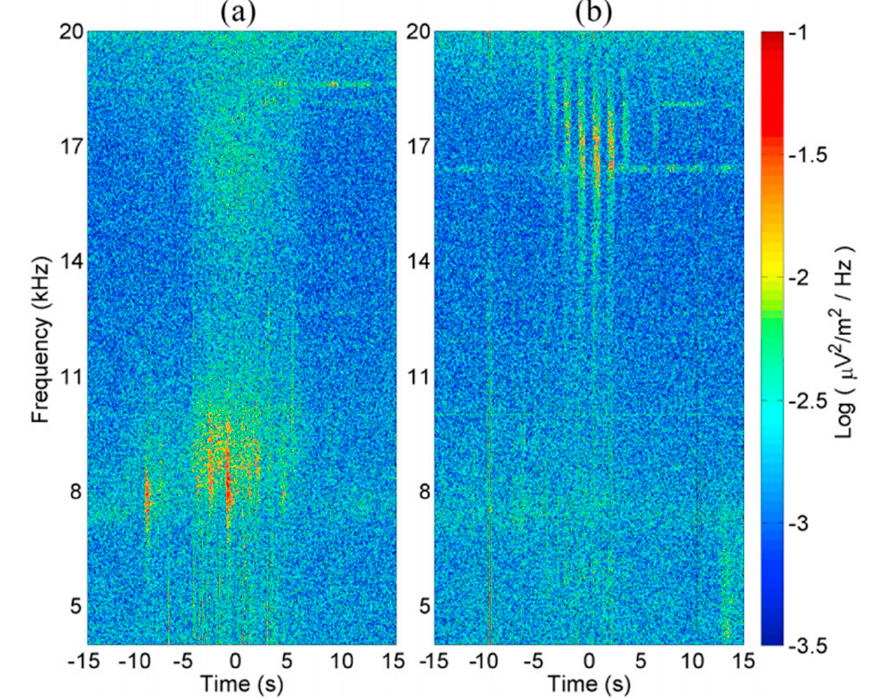
Figure 7. Spectrogram obtained by DEMETER during ( a ) Experiment 1 with CW heating and ( b ) Experiment 2 with 0.7 Hz square pulse modulated heating. In both cases, time = 0 corresponds to the closest approach of DEMETER to the magnetic zenith of HAARP (reproduced with permission from Vartanyan, A., Milikh, G.M., Eliasson, B., Najmi, A.C., Parrot, M., Papadopoulos, K., Genera- tion of whistler waves by continuous HF heating of the upper ionosphere; published by John Wiley and Sons, 2016 [20]).